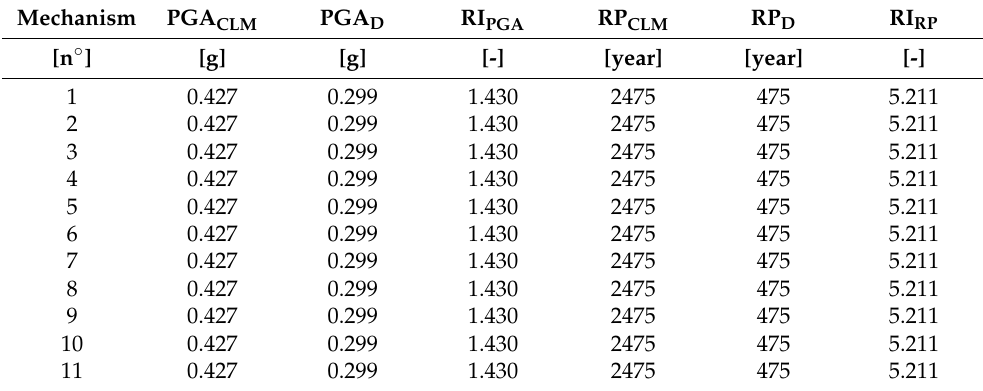
Figure 12. Local collapse mechanisms for the retrofitted configuration. Table 7. Risk indices calculated for the different local collapse mechanisms (retrofitted configura- tion).